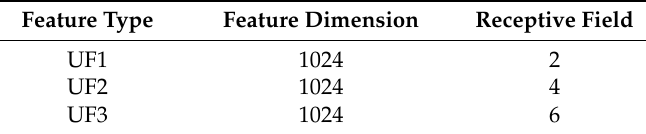
Table 1. Feature set for remote sensing images.